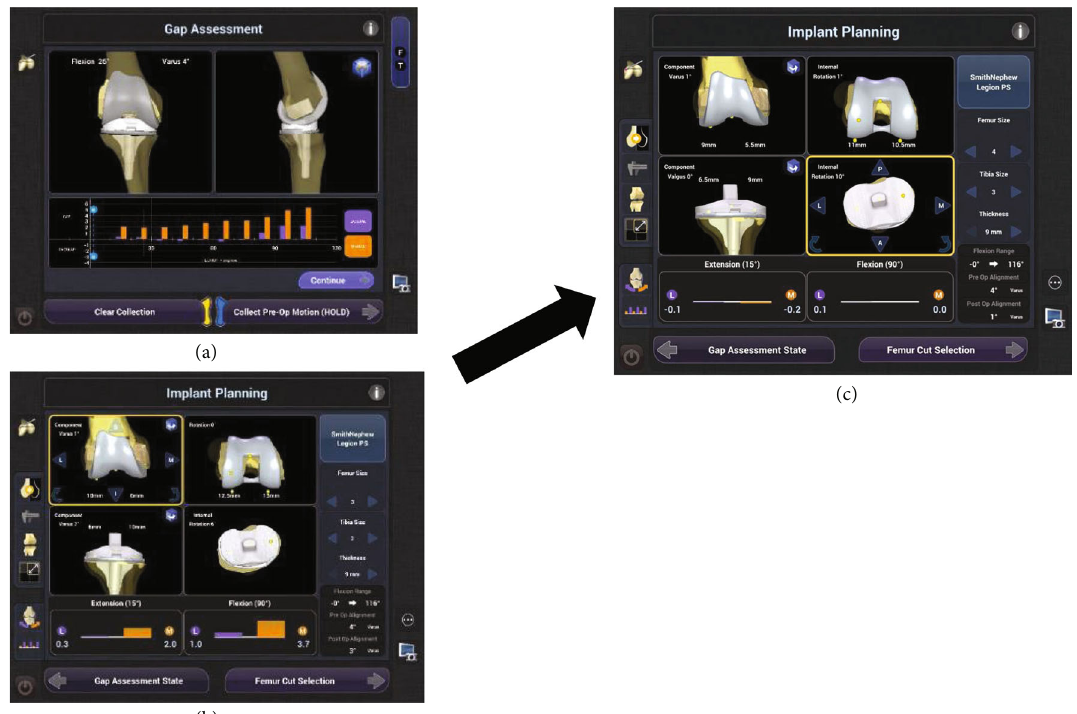
Figure 4: Patient-speci fi c planning. (a) A varus/valgus stress test was performed with a manual max through a full range of motion. (b) The medial gap was enlarged with fl exion, and mild lateral contracture was observed. Due to reduction as much medial looseness from extension to fl exion and lateral contracture from extension to mid fl exion, femoral and tibial components were performed in valgus alignment and we fi ne-tuned the amount of osteotomy. (c) Medial and lateral gaps became